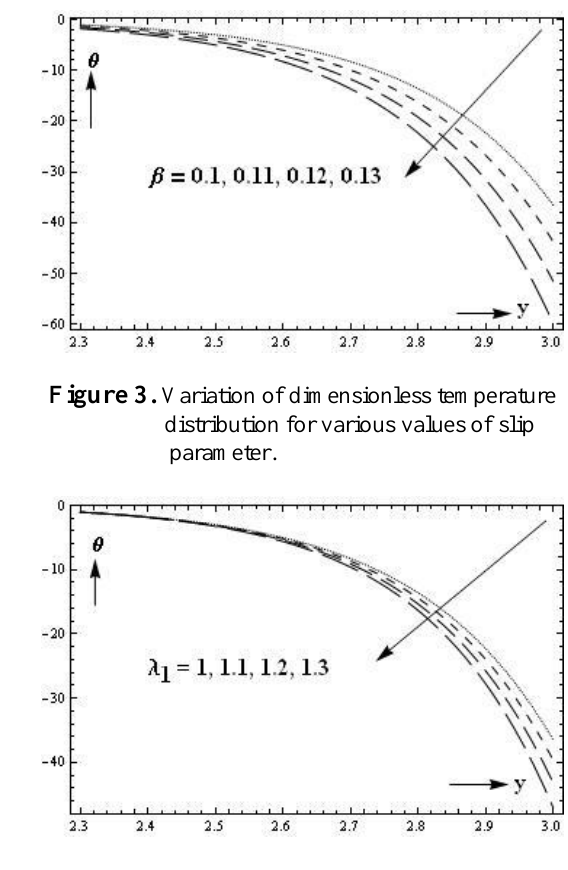
Figure 5. Variation of dimensionless temperature distribution for various values of Jaffrey